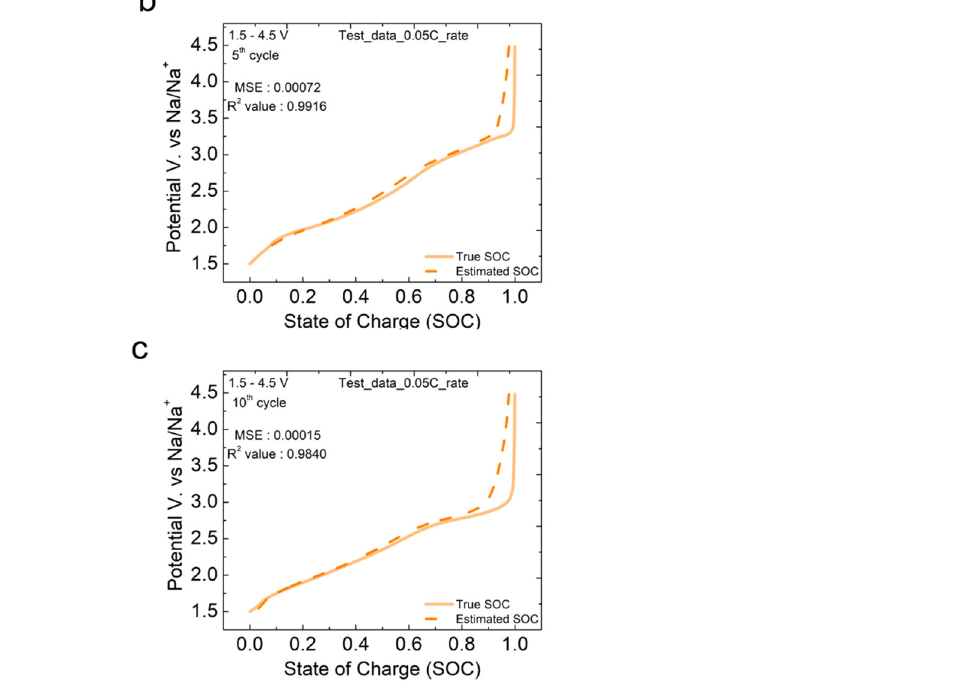
Figure 8. Performance of the FNN model shown using voltage vs. State of charge graph rates by comparing the true and estimated values. Data used are for battery discharged cycled between 1.5–4.5 V vs. Na/Na + at a 0.05 C rate of ( a ) 2nd cycle, ( b ) 5th cycle, and ( c ) 10th cycle. Mean square value and R 2 value are mentioned on each graph.